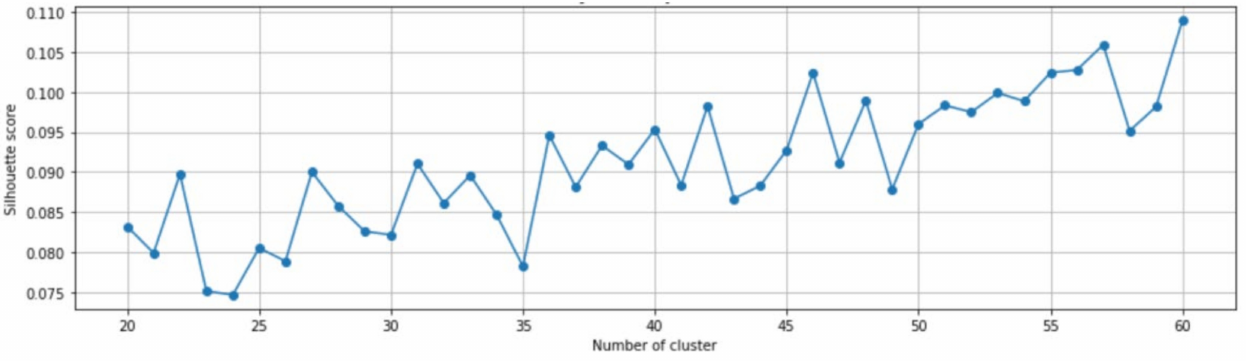
Figure 12. Silhouette analysis for selecting optimal cluster